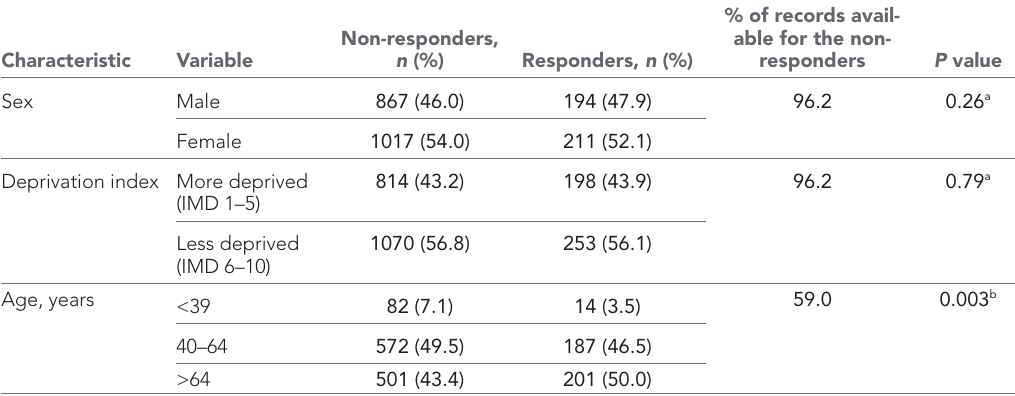
Table 5 Comparison of demographic characteristics of responders and non- responders (London)